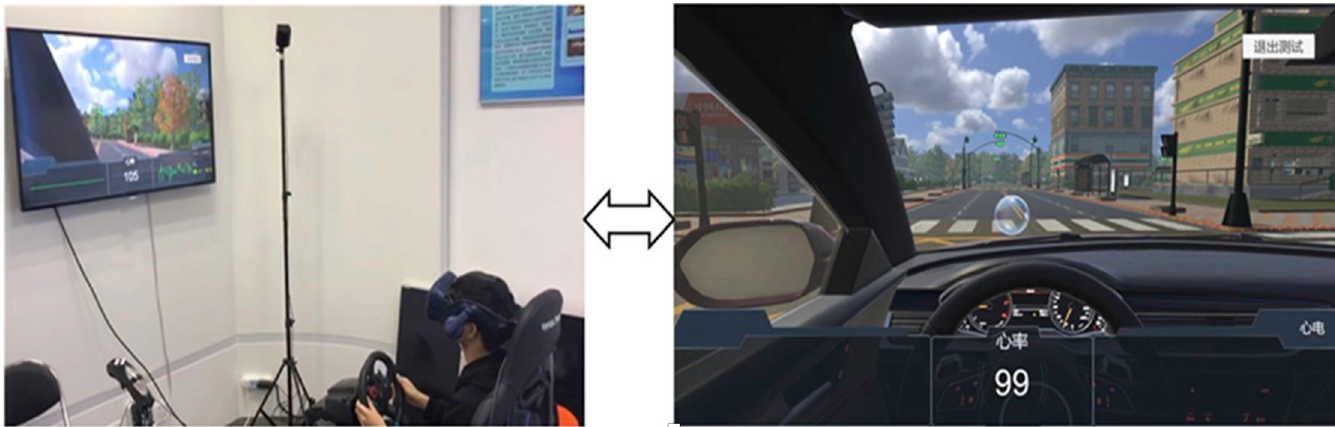
Fig 1. VR driving system. A participant driving in the virtual system (left) and a snapshot containing the ego vehicle, sample of the driving route, intersection, and landmark within the virtual system (right).